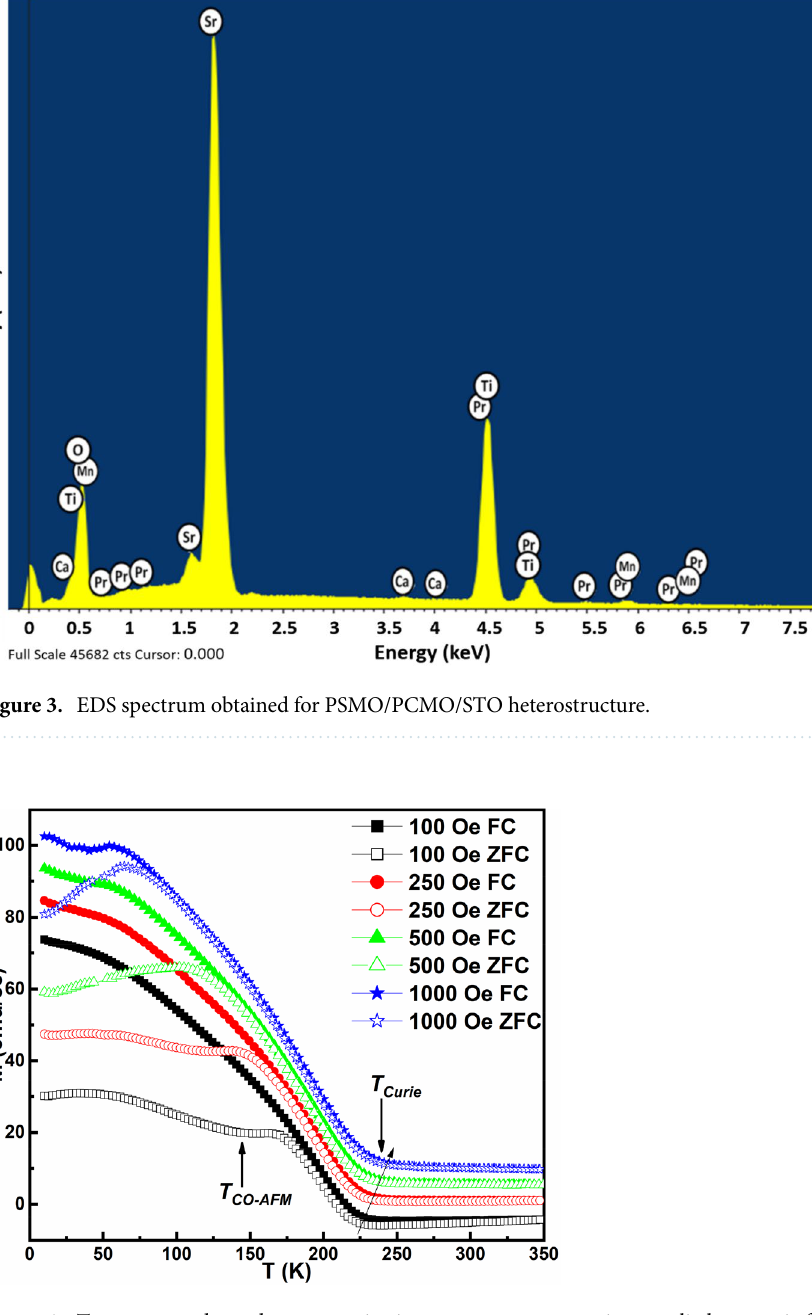
divergence of ZFC and FC curves shows that all the domains are not aligned in the ultra-thin heterostructure. However, the magnetic moment of the ZFC curve at low temperatures is not negligible, as can be seen from the values of the magnetization (M) in the ZFC condition. The obtained M value of 30 emu/cc at 10 K in the ZFC curve of 100 Oe, shows the presence of aligned domains in the ultra-thin heterostructure. The magnetic field-dependent magnetization (M-H) curve for PSMO/PCMO/STO heterostructure at various temperatures is shown in Fig. 5. For 190 K ≤ T ≤ 300 K, the M-H curve exhibits predominantly PM behaviour with unsaturated magnetic moments. For T = 190 K, 200 K, and 210 K, the hysteresis is negligible since the temperature range is close to its T Curie . It is also observed that the magnetic saturation is not reached even under an applied field of 7 T. The absence of magnetic saturation even up to 7 T confirms the presence of antiferromagnetism coexisting in the heterostructure, which may be arising from the AFM state of the PCMO, which failed to get annihilated and is persisting even at high temperatures 29 . The heterostructure exhibits a symmetric hysteresis